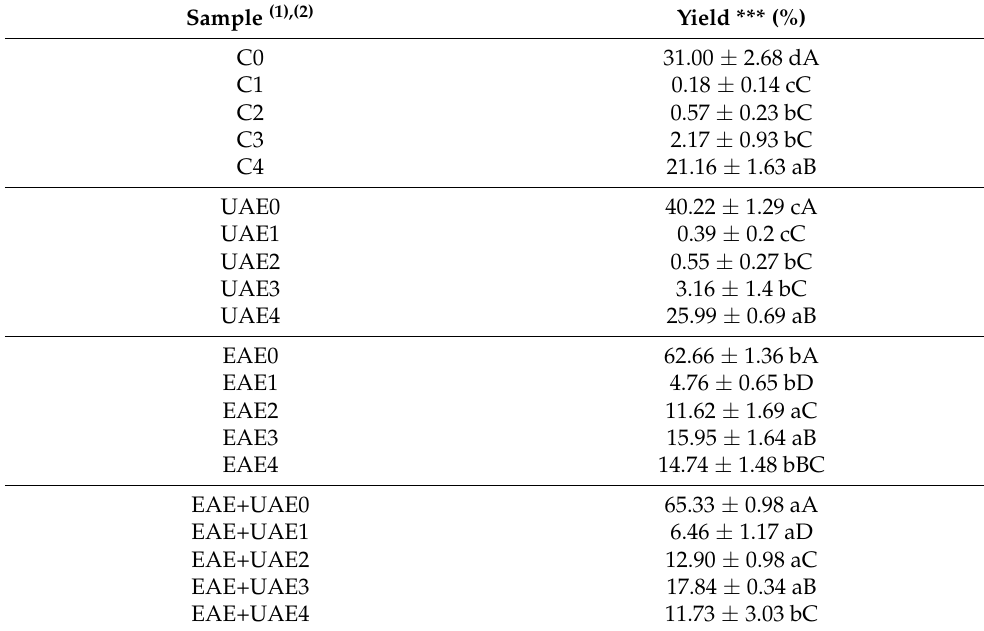
Table 1. The extraction yields of collagen hydrolysates fractions from Alaskan pollock skin